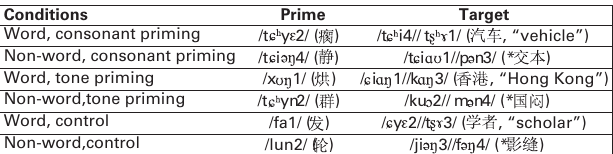
Table 2 | Example materials and experimental conditions in Experiment